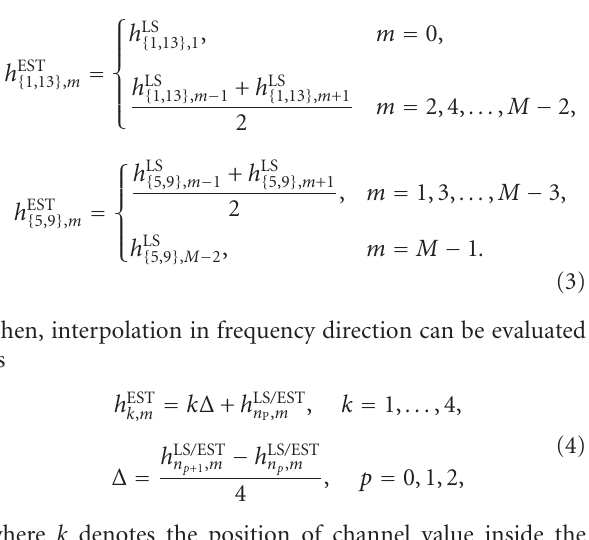
Pilot pattern of a cluster in a DL-PUSC frame of data symbols is shown in Figure 4. Pilots are allocated at subcarrier { 5,9 } for even symbol and at subcarrier { 1,13 } for odd